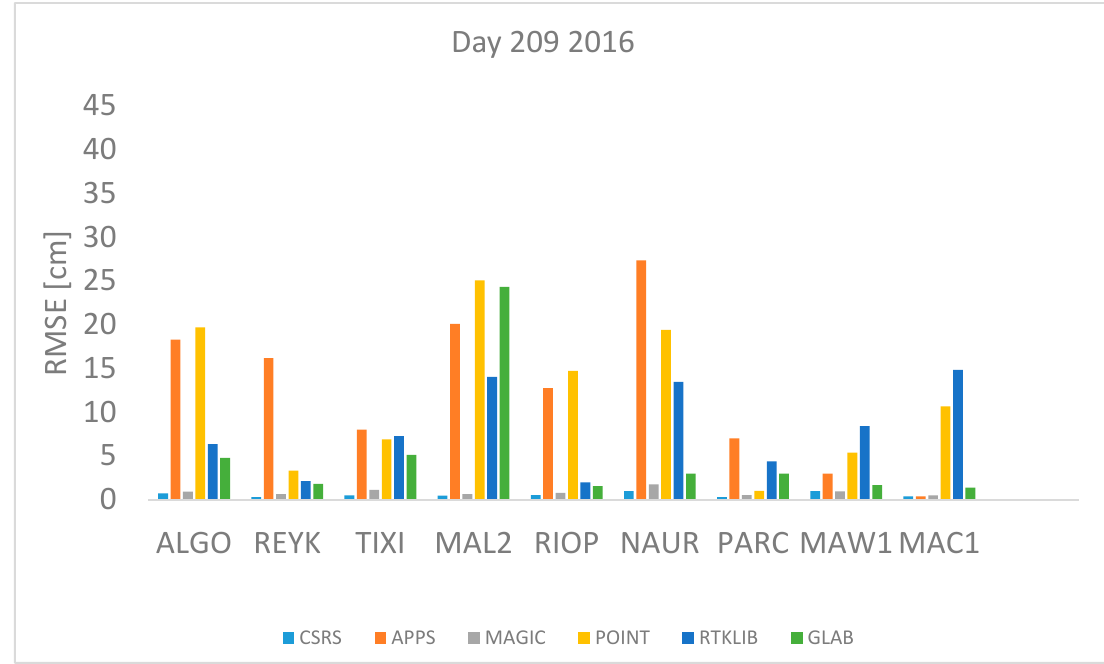
Figure 5. RMSE in centimeters for day 209 2016.